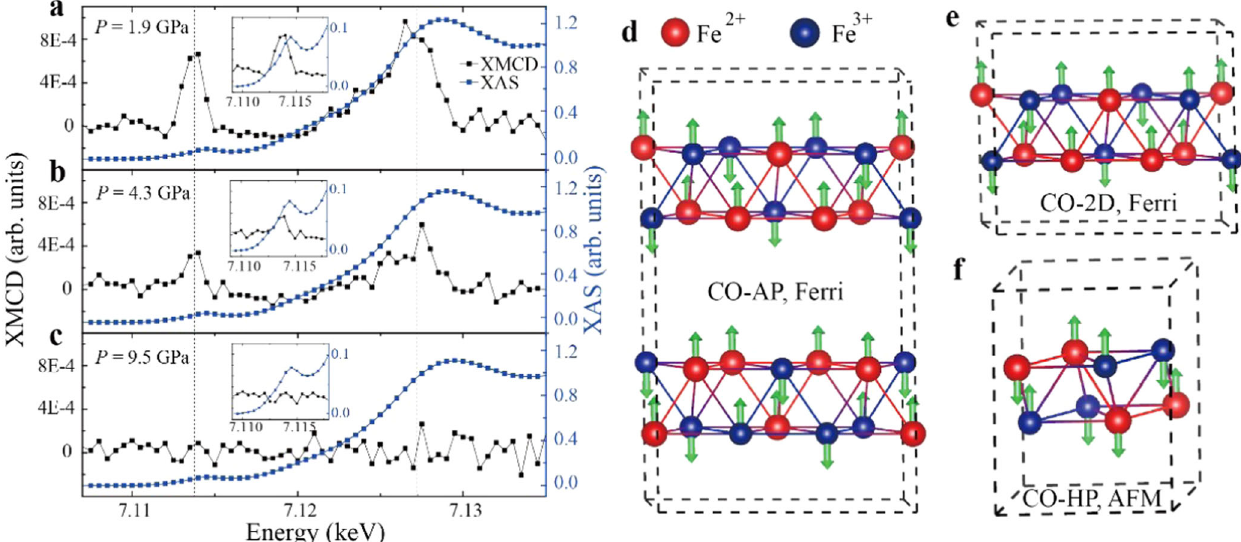
Fig. 3 Magnetic properties of LuFe 2 O 4 under pressure. a – c Fe K-edge X-ray absorption near edge structure (XAS) and XMCD spectroscopy data measured at T = 100 K, H = 5 T, and P = 1.9 GPa ( a ), 4.3 GPa ( b ), 9.5 GPa ( c ), respectively. The pressures correspond to the three observed charge order phases (CO-AP, CO-2D, CO-HP) in LuFe 2 O 4 . Insets of ( a – c ) show the XAS and XMCD data of the pre-edge region at 1.9, 4.3, and 9.5 GPa, respectively. d Ferrimagnetic model for the centrosymmetric CO-AP phase e Ferrimagnetic model for the non-centrosymmetric CO-2D phase f Antiferromagnetic model for the centrosymmetric CO-HP phase for DFT calculations in pressurized LuFe 2 O 4 . (Ferri (ferrimagnetic), AFM